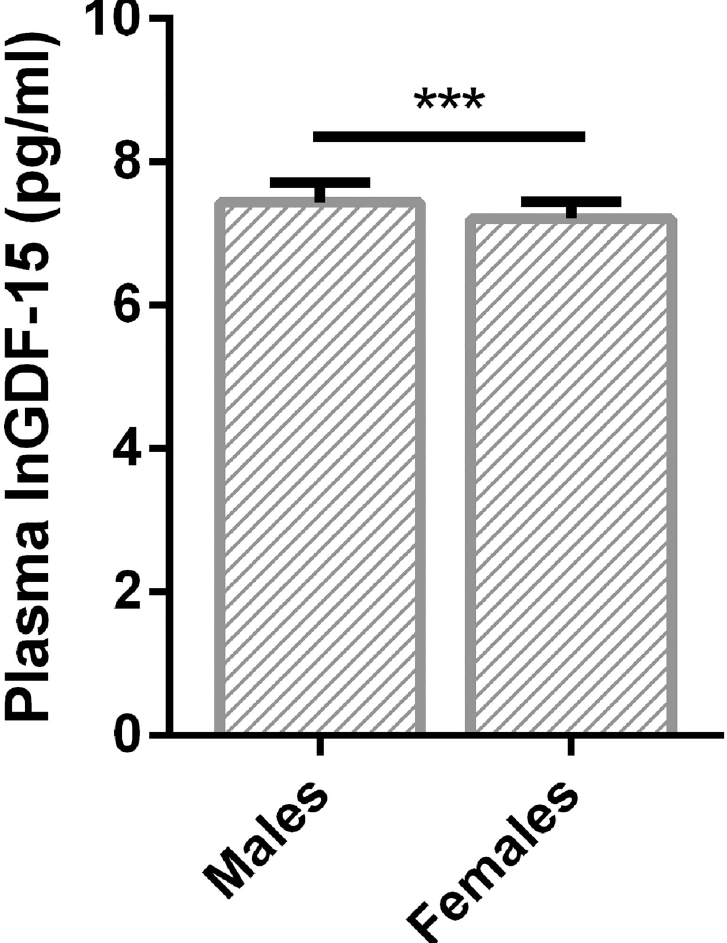
Fig 3. Gender differences in plasma GDF-15 concentration (Ln transformed pg/ml). Males had significantly higher LnGDF-15 compared to females. Median and interquartile range are depicted. ��� p < 0.001.